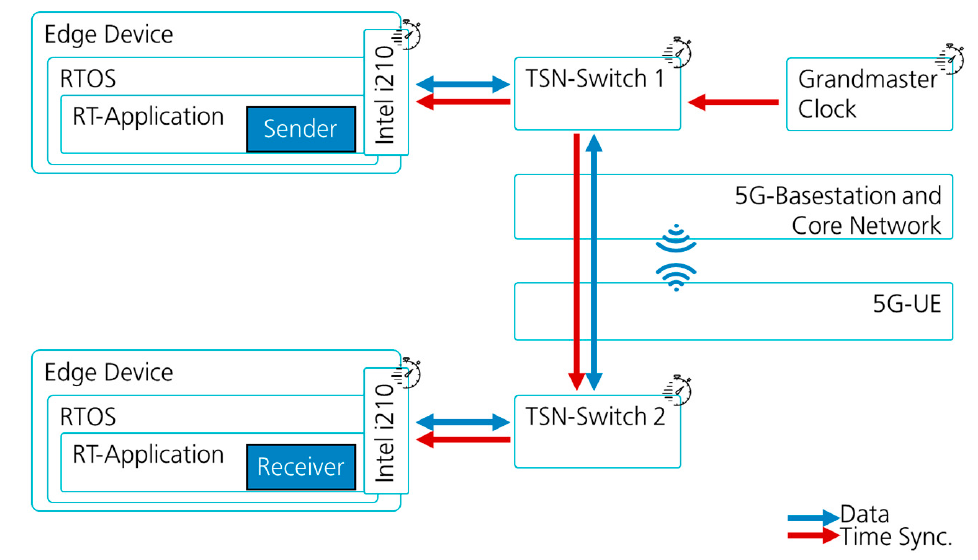
Figure 7. Integration of the 5G-URLLC system in the TSN based network.